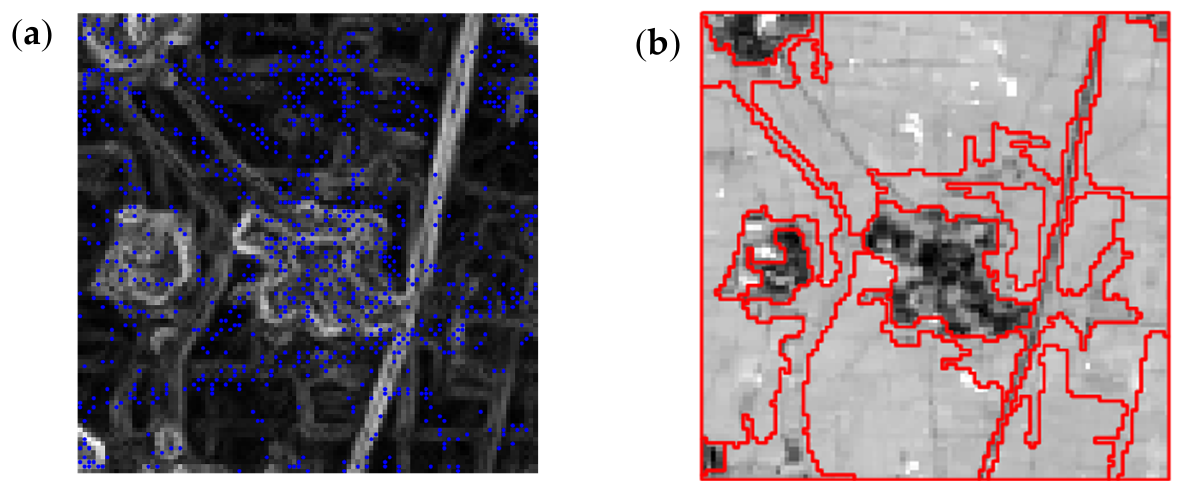
Figure 5. ( a ) The distribution of seed locations on the gradient image and ( b ) its corresponding segmented result (115.9072 ◦ E–115.9344 ◦ E, 35.68809 ◦ N–35.71531 ◦